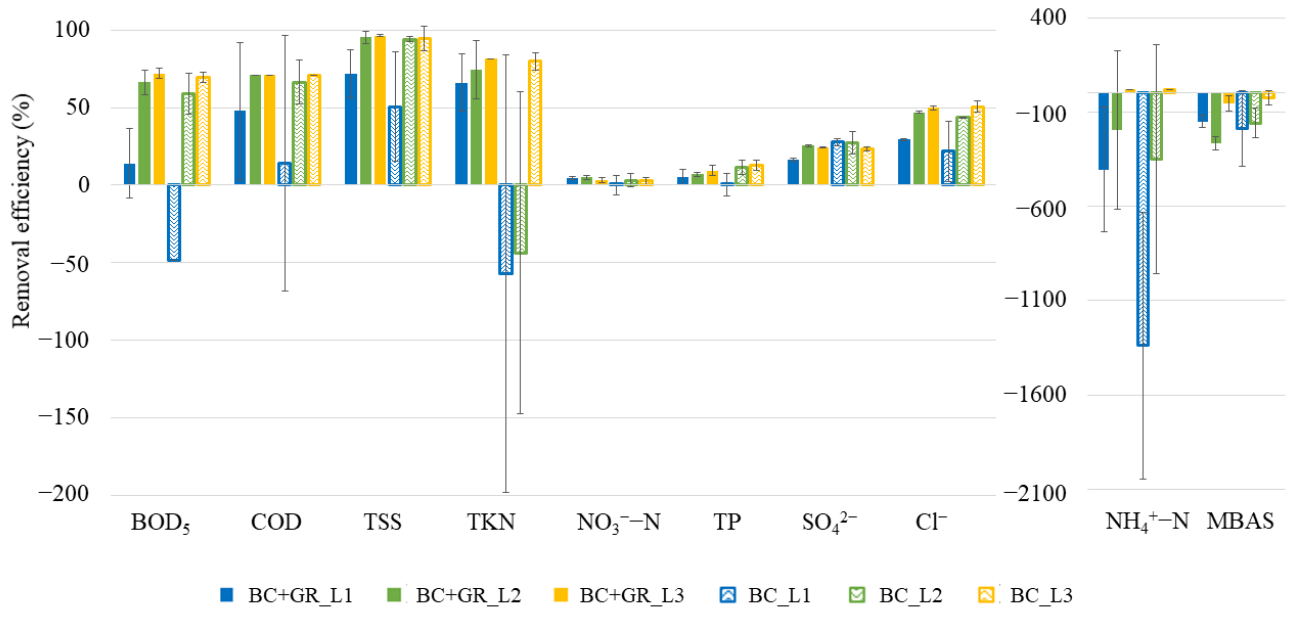
Figure 5. Removal efficiency for different treatment levels.